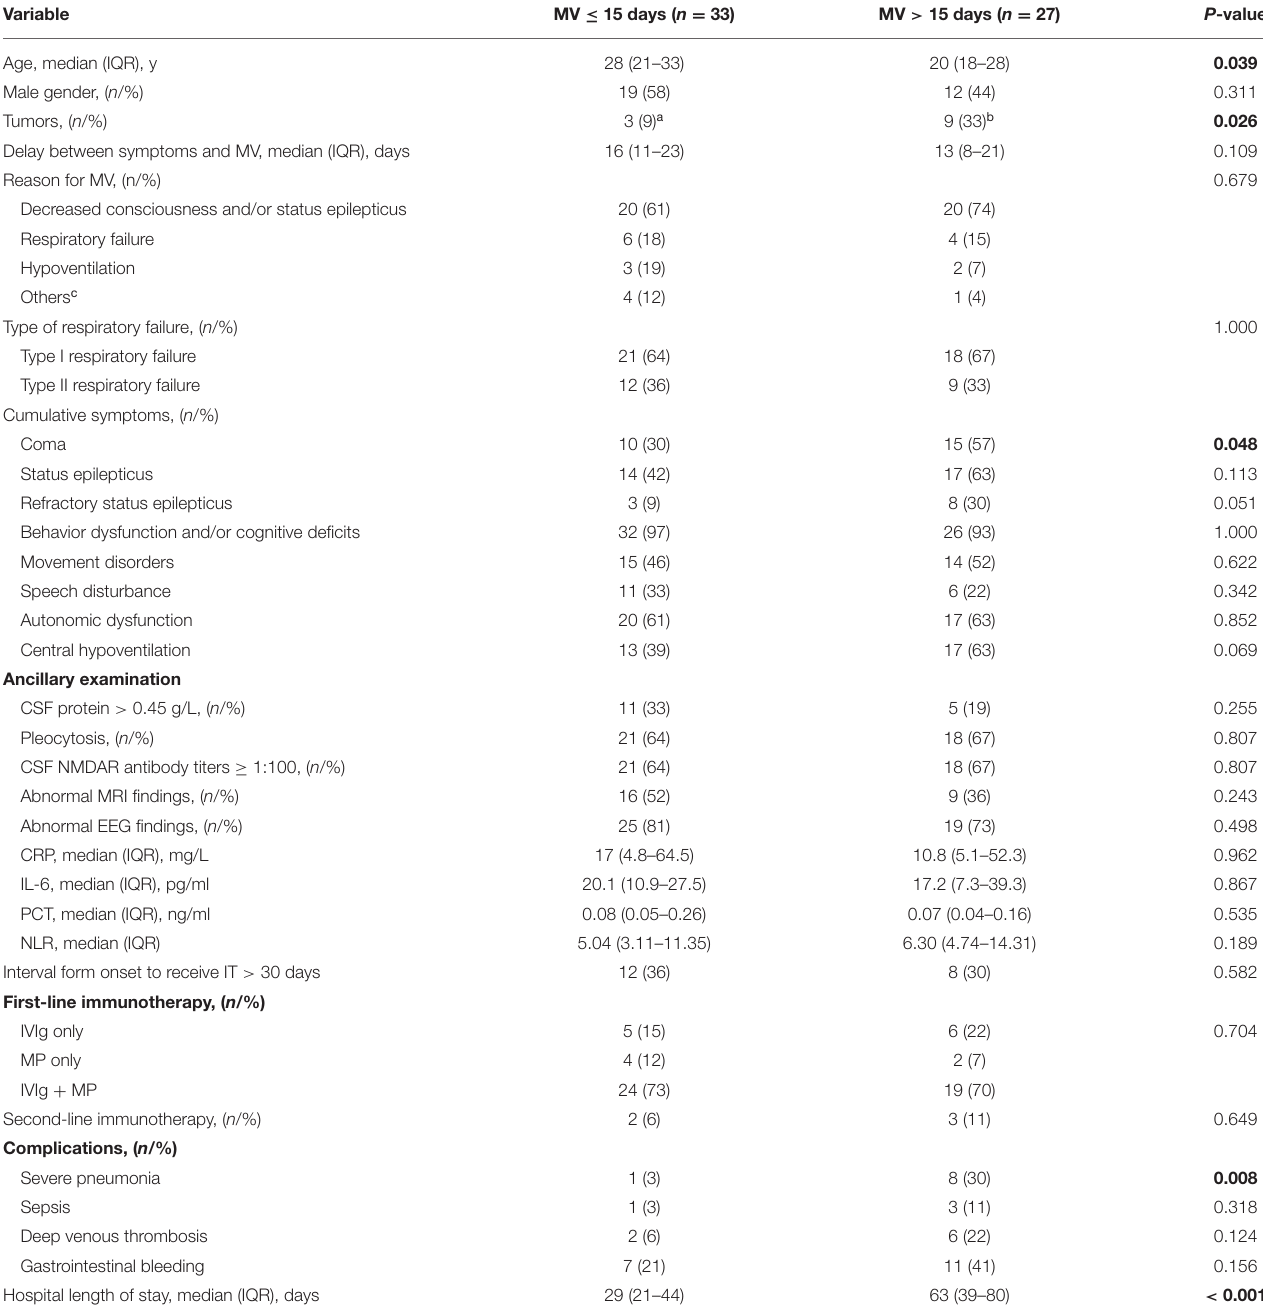
TABLE 3 | Characteristics in prolonged MV patients compared with short MV patients.